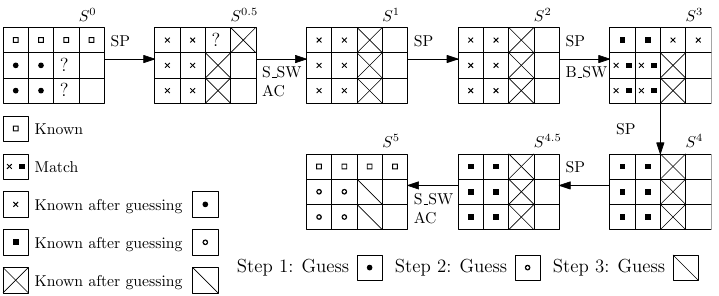
Figure 7: Generate a valid inner part for the preimage attack on 5-round Gimli-Hash